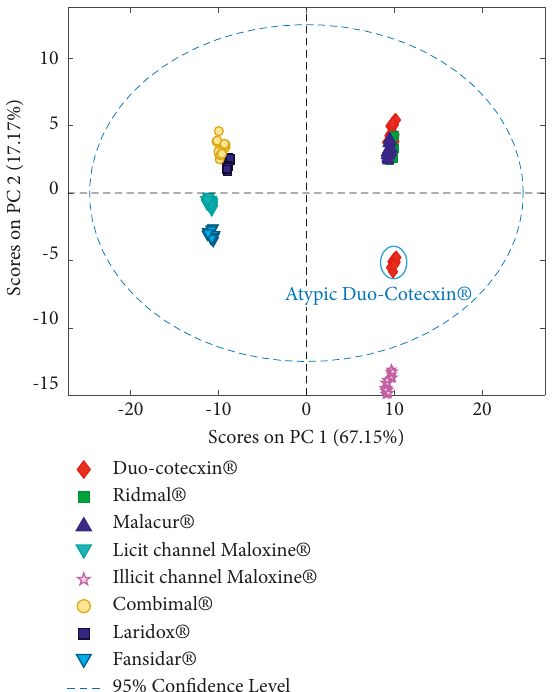
Figure 2: PC1-PC2 score plot of the preprocessed data of both SP and DP